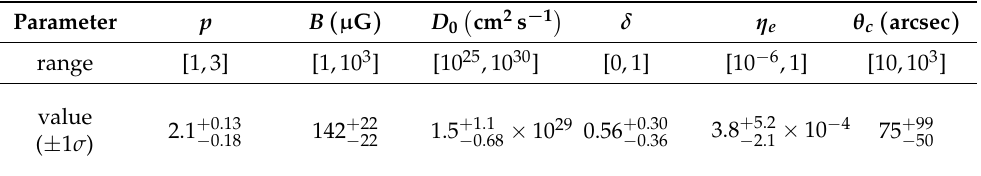
Table 3. First row: model parameters; second row: searching range of parameters in MCMC; third row: best-fit values and 1 σ uncertainties. Among the six parameters, B , D 0 , η e and θ c take the logarithm in